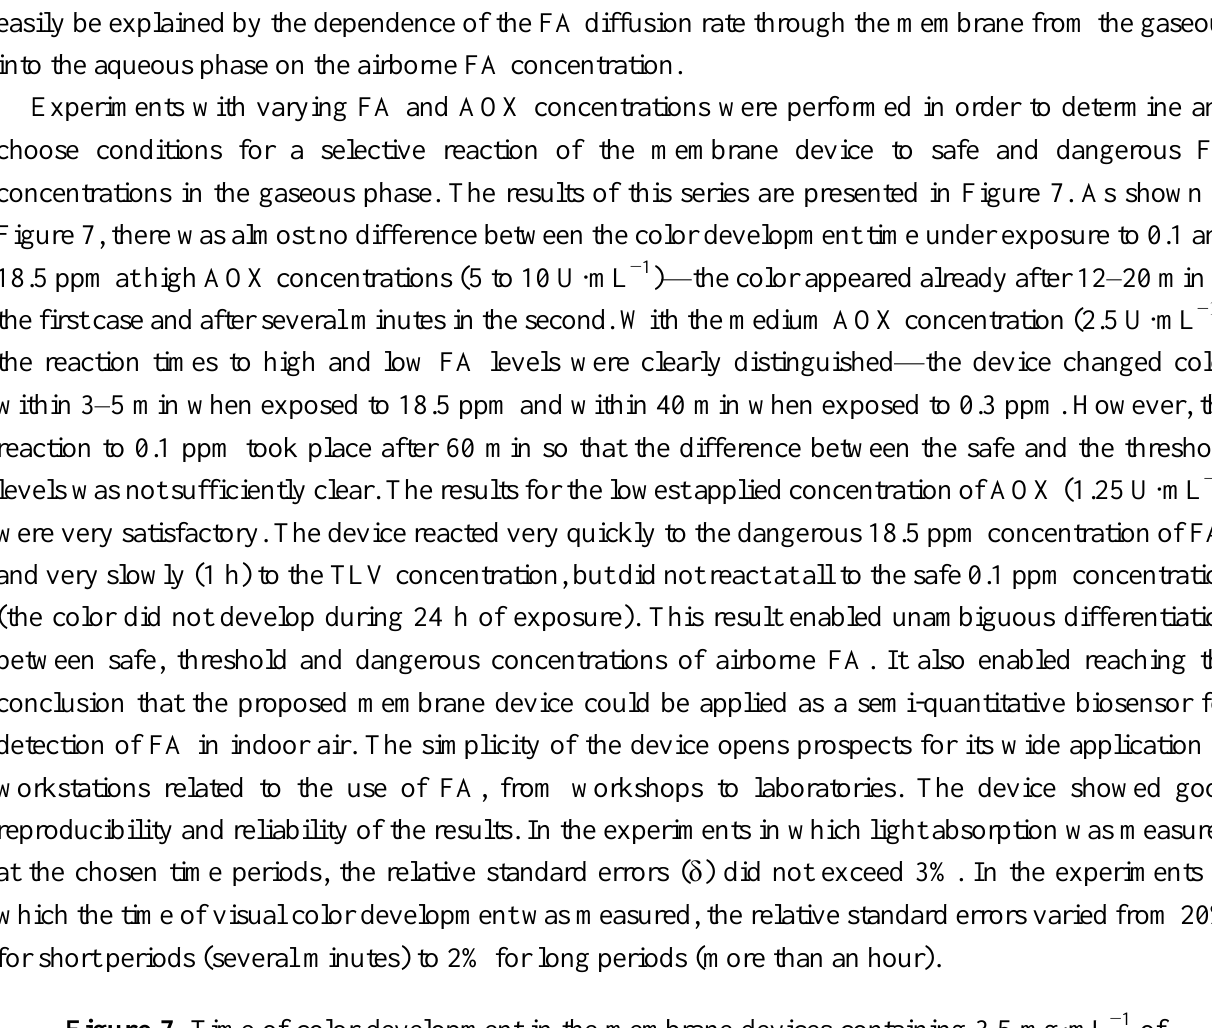
Figure 7. Time of color development in the membrane devices containing 3.5 mg·mL −1 of HRP, 2 mg·mL −1 of chromogen and various concentrations of AOX. The devices were exposed to airborne FA at various concentrations, and the reaction time was